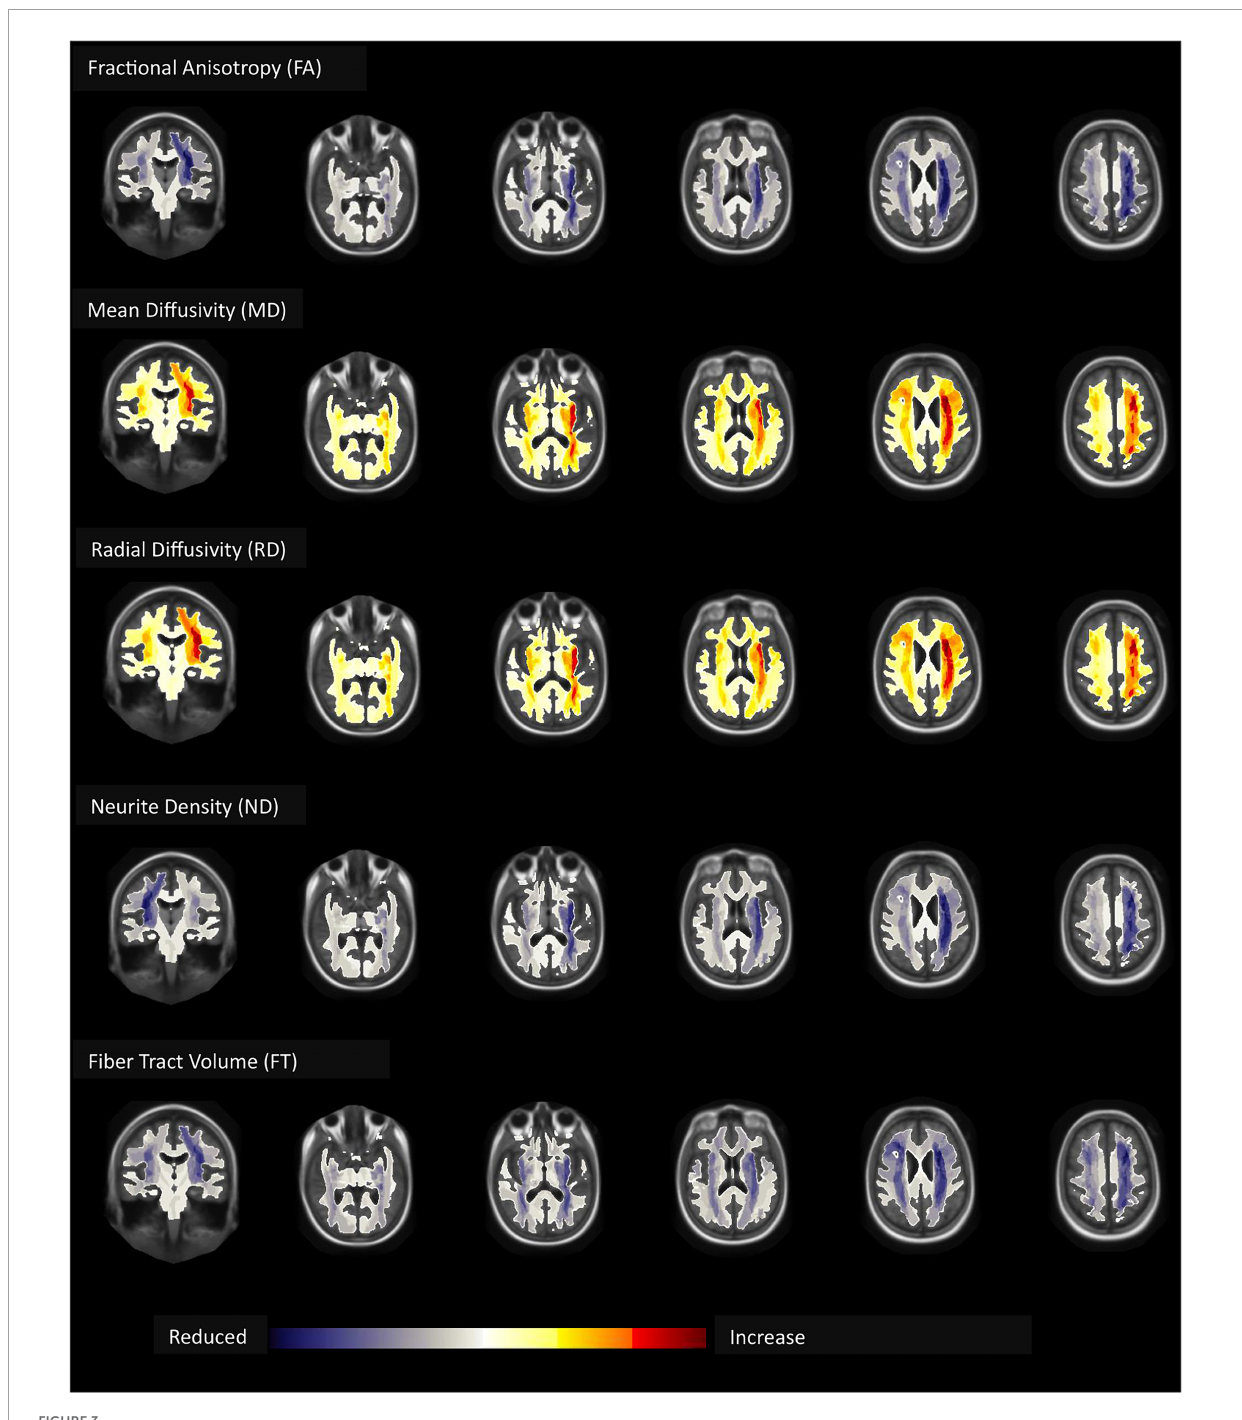
FIGURE3 Children with ADHD compared to those without had lower fractional anisotropy (FA), neurite density (ND), and fiber tract (FT) volume but higher mean (MD) and radial (RD) diffusivity – most pronounced in the frontal and parietal white matter – independent of age, biological sex, race, handedness, and highest parental education as a marker of socioeconomic status, and after correction for multiple